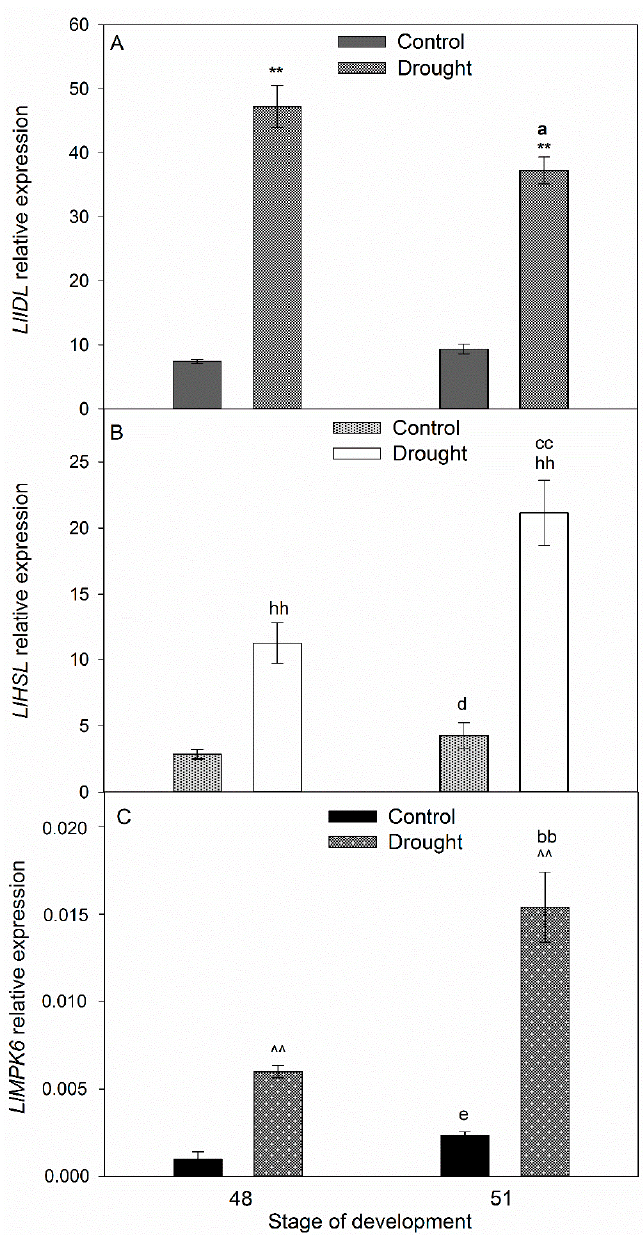
Figure 3. Transcriptional activity of LlIDL ( A ), LlHSL ( B ), and LlMPK6 ( C ) (related to LlACT ) in the yellow lupine flower abscission zone (AZ) subjected to drought. Control plants were growing in soil of optimal moisture (70% WHC), while part of plants was subjected to drought conditions for 2 weeks (25% WHC). For gene expression profiling, AZs were harvested on the 48th and 51st days of cultivation. Data are presented as averages ± SE. For LlIDL expression, significant di ff erences in stressed plants in comparison to control plants are indicated as ** p < 0.01, and significant di ff erences in 51-day-old stressed plants in comparison to 48-day-old plants are indicated as a p < 0.05. For LlHSL, significant di ff erences in stressed plants in comparison to control plants are indicated as hh p < 0.01, significant di ff erences in 51-day-old control plants in comparison to 48-day-old plants are indicated as d p < 0.05, and significant di ff erences in 51-day-old stressed plants in comparison to 48-day-old stressed plant are indicated as cc p < 0.01. For LlMPK6, significant di ff erences in stressed plants in comparison to control plants are indicated as ˆˆ p < 0.01, significant di ff erences in 51-day-old control plants in comparison to 48-day-old plants are indicated as e p < 0.05, and significant di ff erences in 51-day-old stressed plants in comparison to 48-day-old stressed plants are indicated as bb p < 0.01 (Student’s t